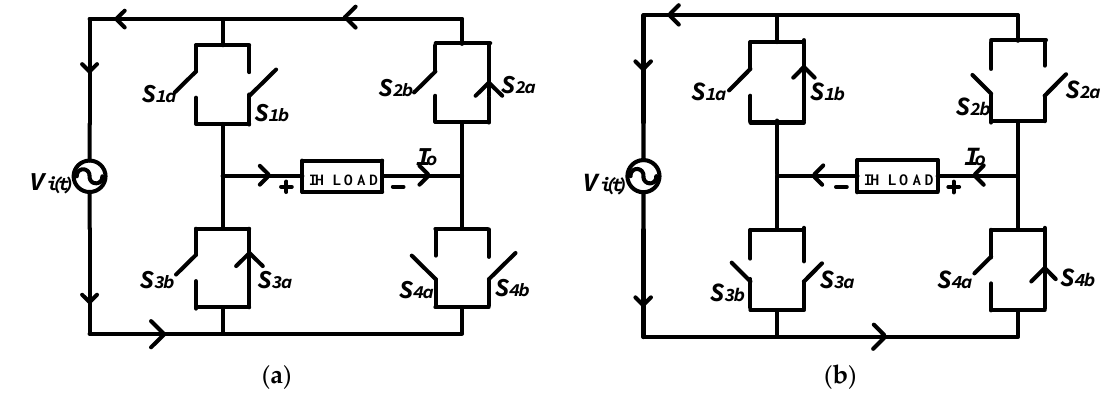
Figure 6. Negative mode of operation ( a ) Mode 3 and ( b ) Mode 4.